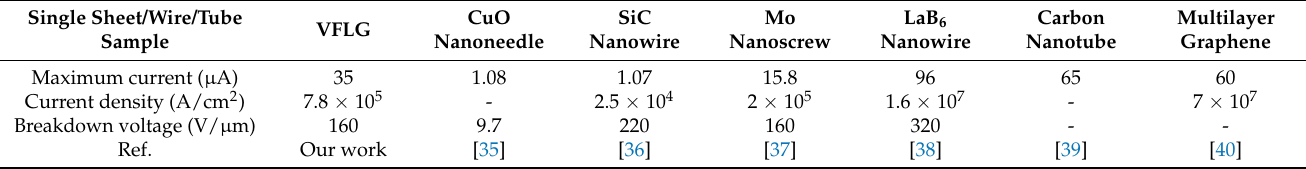
Table 3. Comparison of the high emission current/current density/breakdown voltage of the reported single sheet/wire/tube nanomaterials.